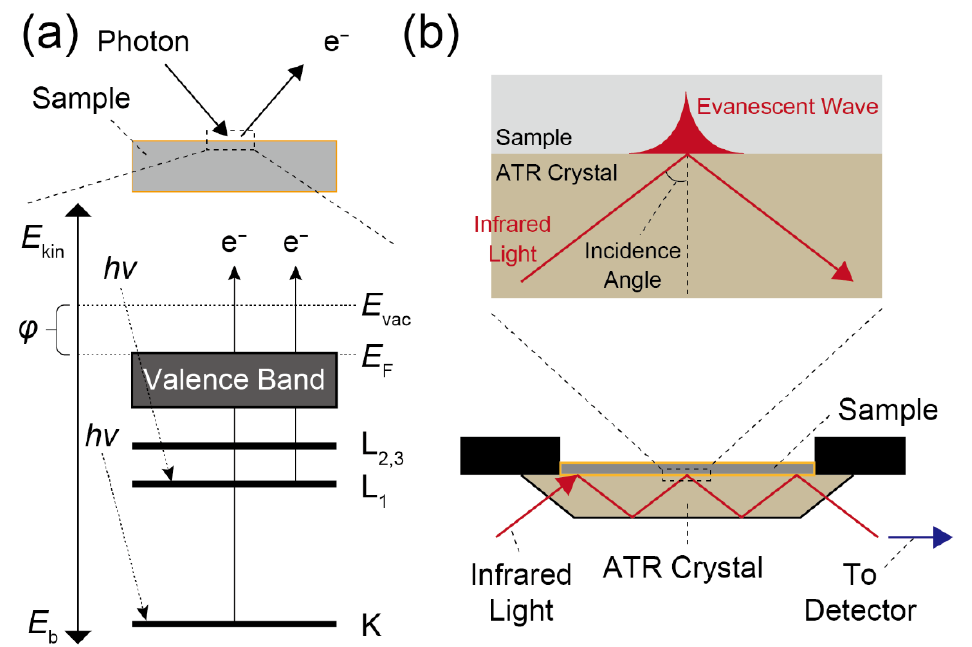
Figure 5. ( a ) Schematic energy diagram in the XPS measurement. ϕ indicates the work function of the sample. ( b ) Illustration of a multiple-reflection type ATR system.